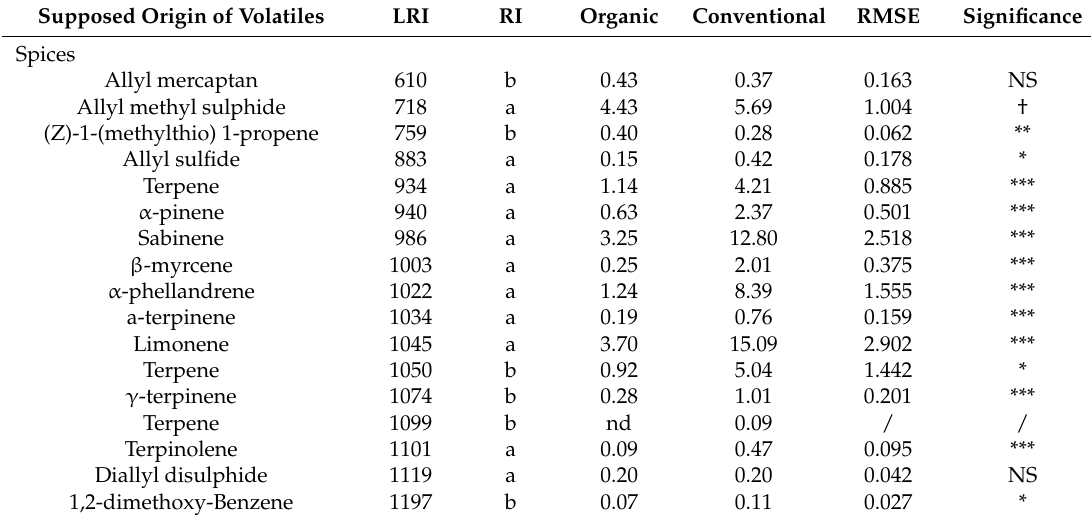
Table 3. Volatile compounds (expressed as normalized area (Area Comp/Area IS); IS=2-methyl-3-heptanone) of dry-fermented sausages (six per treatment group) manufactured without nitrite addition made of pork from organic or conventional husbandry system.